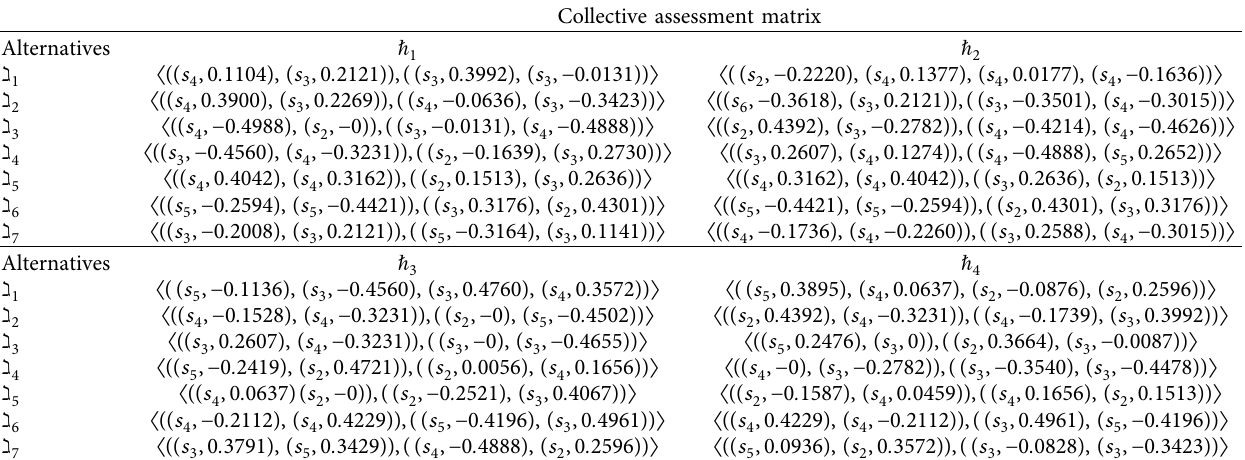
Table 5: Collective the 2TLC q -ROF assessing matrix by the 2TLC q -ROFHWA